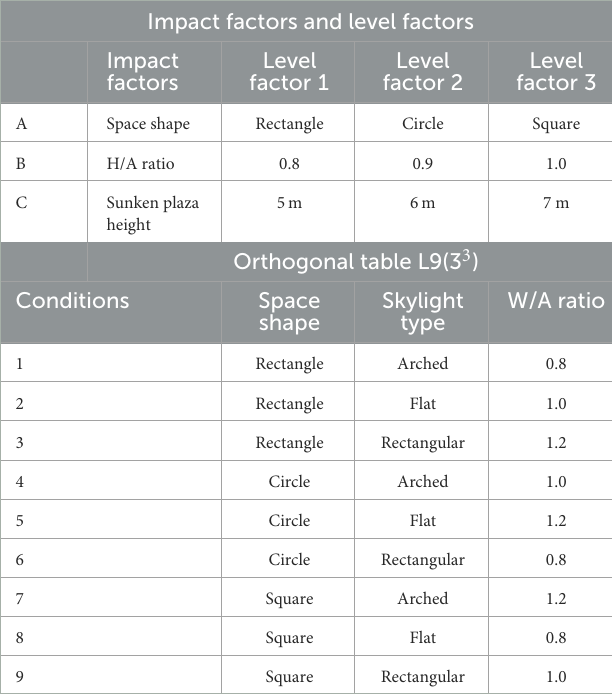
TABLE 3 Impact factors, level factors, and orthogonal table of TUAI, TCAI, and THAI.